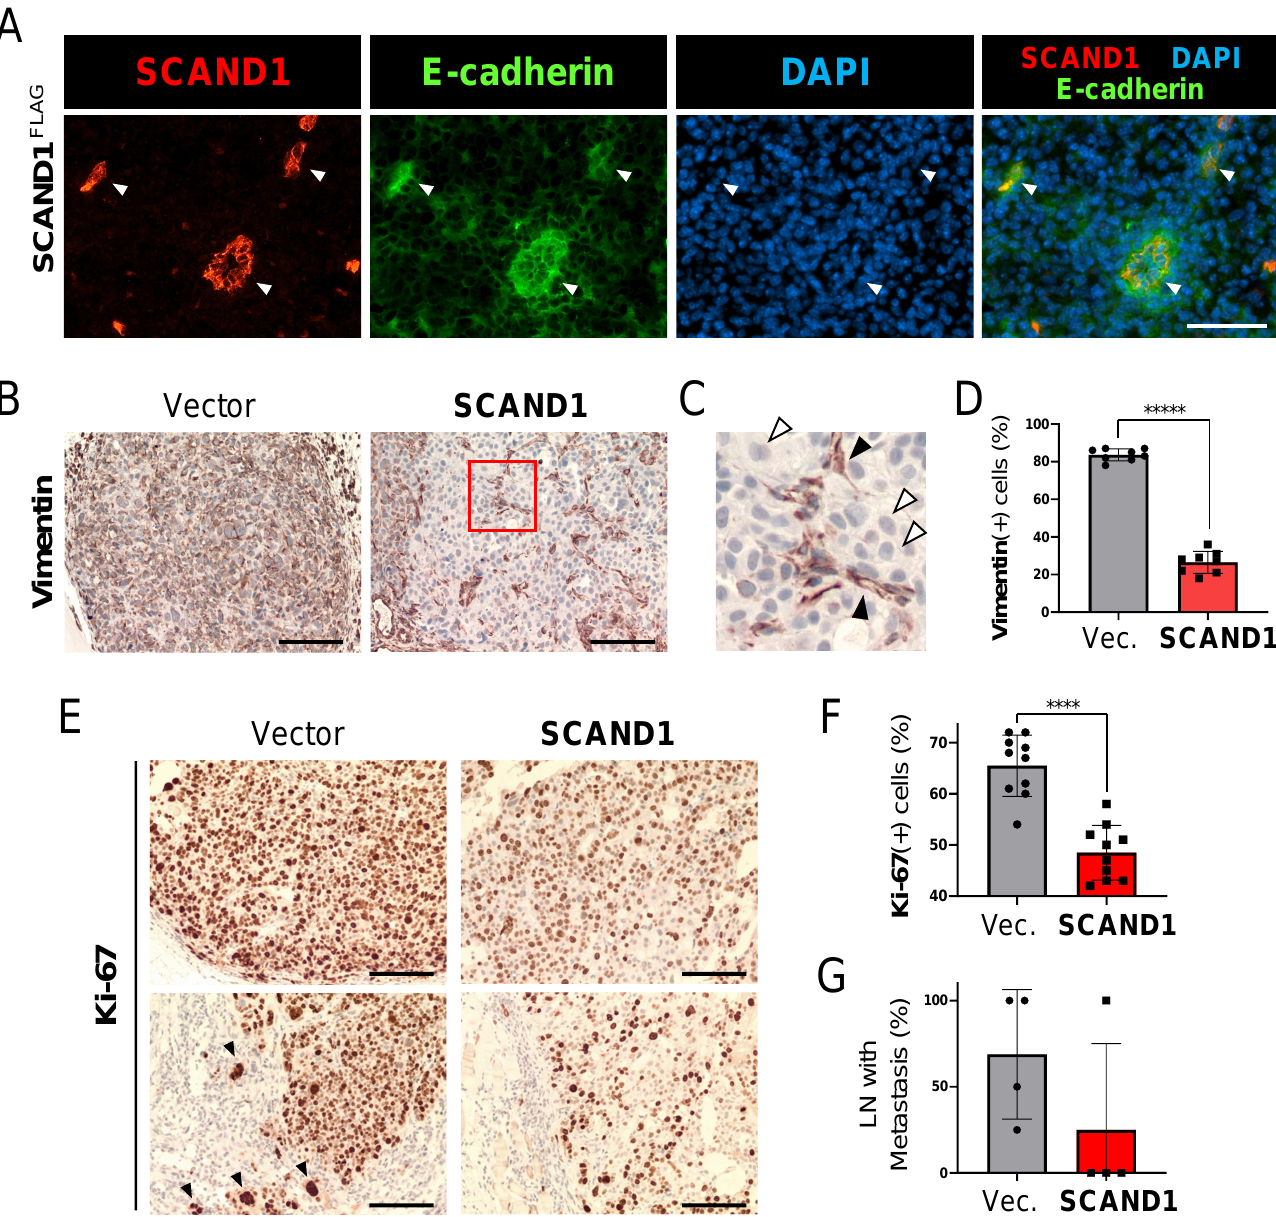
Figure 5. SCAND1 inhibits EMT, collective migration, and lymph-node metastasis in vivo. SCAND1- overexpressed or the control vector-transfected DU-145 cells were subcutaneously transplanted into mice. Tumors were resected, and IHC was performed. ( A ) Co-expression of SCAND1 and E-cadherin in the tumor overexpressed with SCAND1. Arrowheads indicate co-expression. Scale bars, 50 µ m. ( B , C ) IHC for Vimentin. ( C ) A magnified image showing vimentin(+) cells (black arrowheads) and Vimentin(-) cells (white arrowheads) in the SCAND1 overexpressing tumor. Scale bars, 50 µ m. ( D ) Column scatter plotting showing the rate of vimentin(+) cells. ***** n = 8 fields, p < 0.000000000001. ( E ) IHC for Ki-67 in the center of tumors (upper panels) and tumor–stroma border areas (lower panels). Arrowheads indicate collectively migrating cancer cells at an invasive front into the stroma. Scale bars, 50 µ m. ( F ) The rate of Ki-67(+) cells. **** n = 10 fields, p < 0.0001. ( G ) The rate of lymph nodes with metastasis in each mouse. n = 4